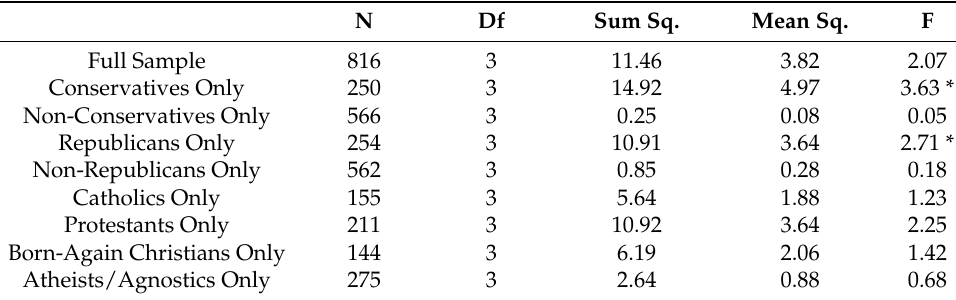
Table 4. Summary of experimental effects on religious liberty threat perceptions.